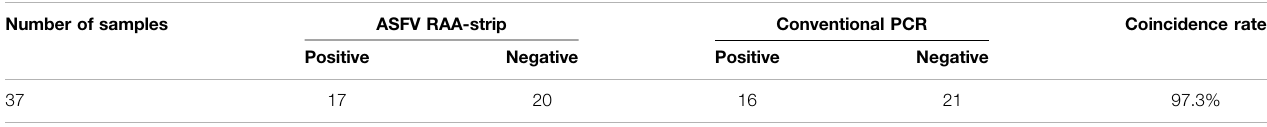
TABLE 2 | Comparison of ASFV RAA-strip and conventional PCR in clinical samples. Number of